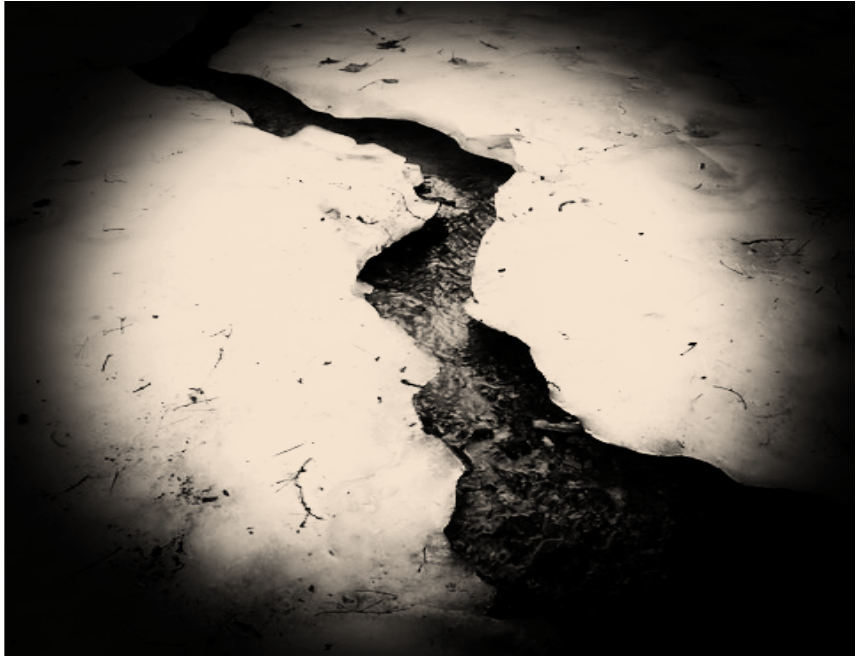
Figure 4. Earthly Bodies, Embodying